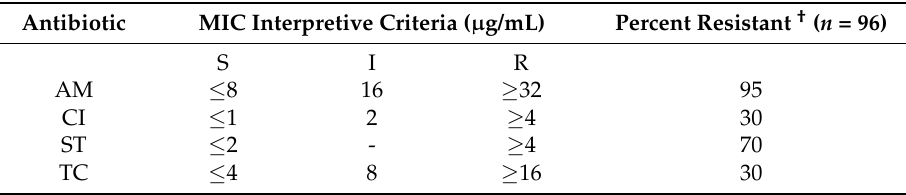
Table 4. Percentage of antibiotic resistant E. coli isolates.